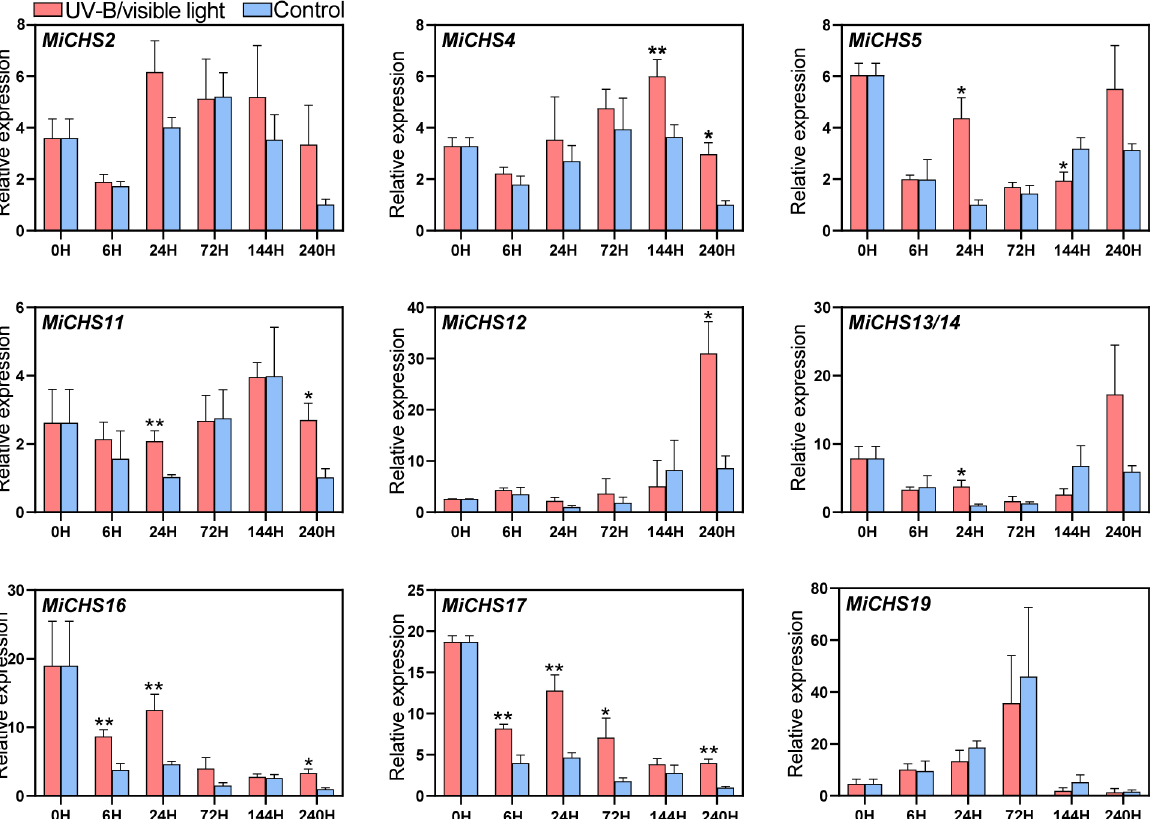
Figure 7. The expression of CHS genes in ‘Hongmang NO. 6’ mango peel was analyzed using a UV-B/visible light treatment and control (dark). The data represent the mean value ± SD, n = 3. * indicates a significant difference ( p -value < 0.05). ** indicates a very significant differences ( p -value < 0.01), as determined by Student’s t -test.